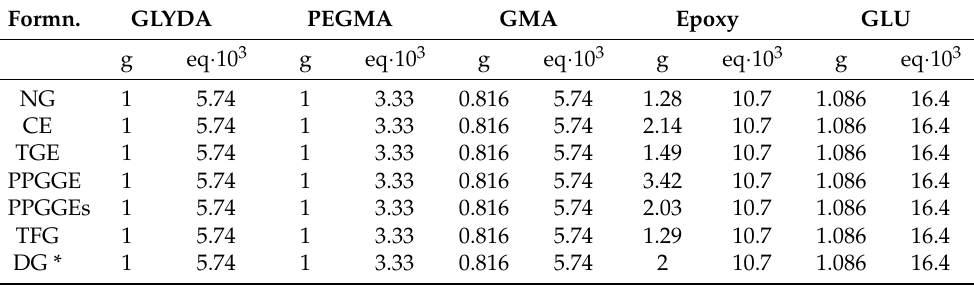
Table 3. Formulations containing different epoxides. Formn. GLYDA PEGMA